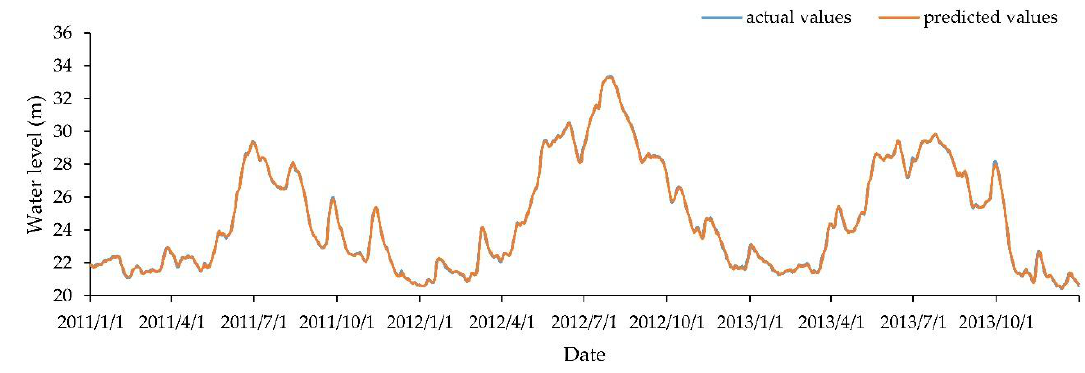
Figure 7. Forecasting results of the Dongting Lake water level using the LSTM model.